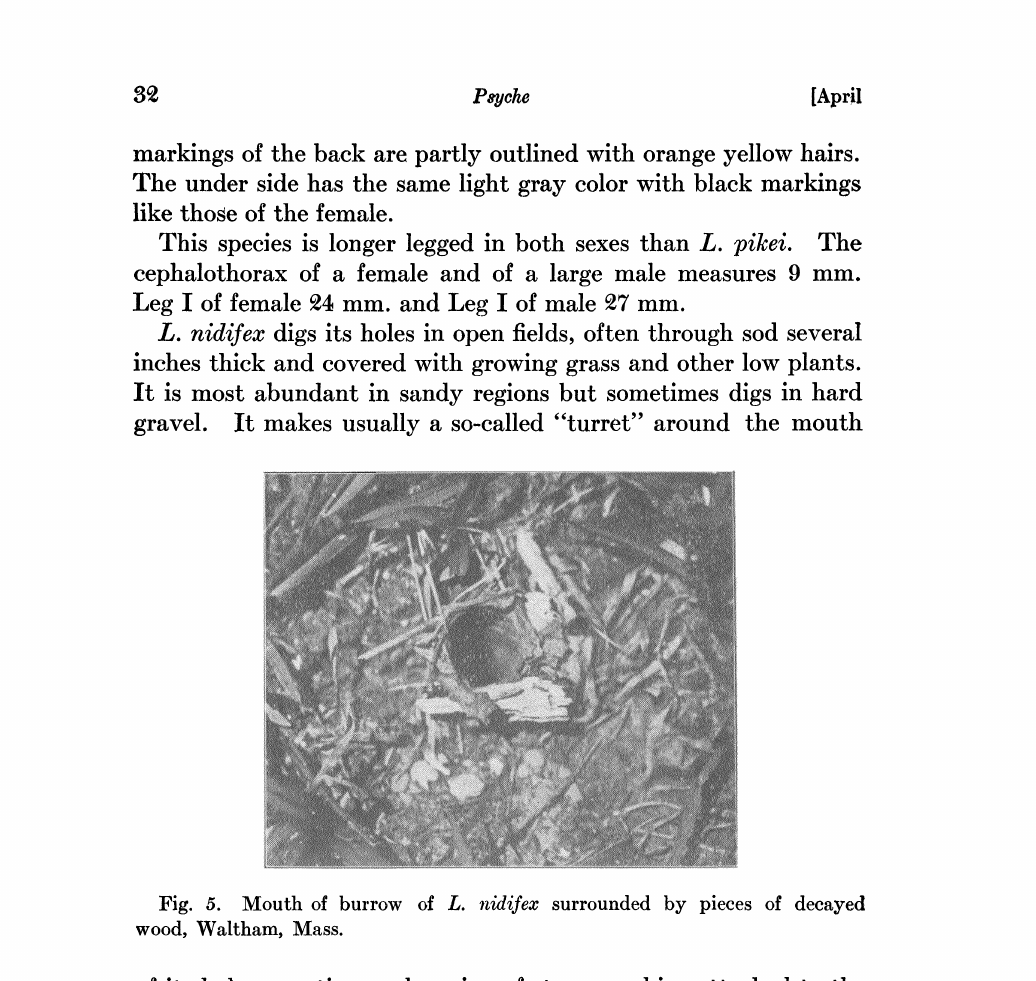
Fig. 5. Mouth of burrow of L. nidifex surrounded by pieces of decayed wood, Waltham,